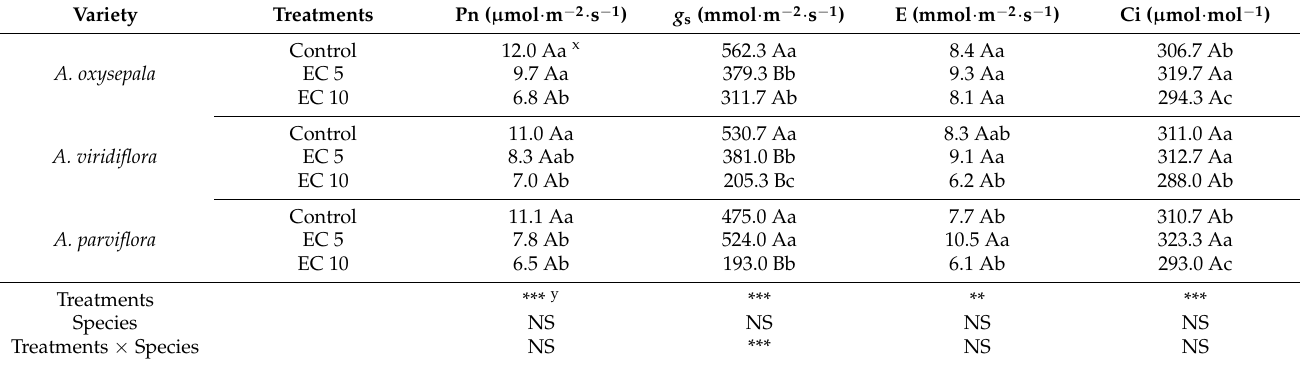
Table 8. Net photosynthesis (Pn), stomatal conductance ( g s ), leaf transpiration rate (E), and intercel- lular CO 2 concentration (Ci) of A. oxysepala , A. parviflora , and A. viridiflora irrigated with tap water (control) and salt solution at an electrical conductivity (EC) of 5 dS · m − 1 (EC 5) and 10 dS · m − 1 (EC 10).